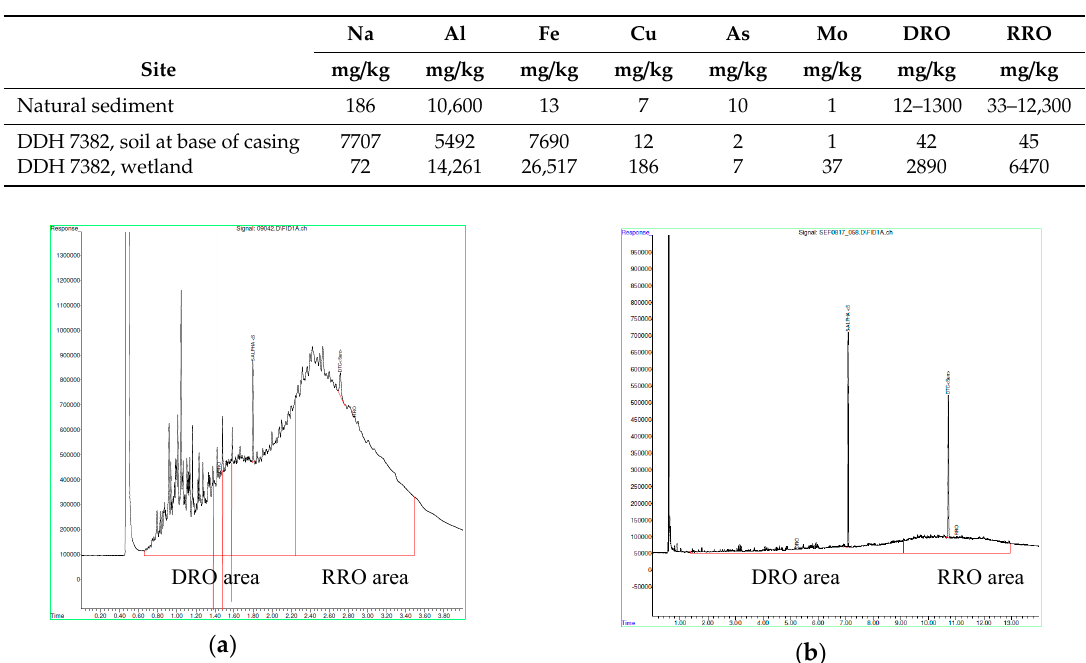
Table 3. DDH 7382, sediment. A putty-like material at the base of the leaking casing was sampled, along with wetland sediment several meters downgradient. “Natural Sediment” ( n = 197) is median concentrations from PLP [21], except Diesel Range Organics (DRO) and Residual Range Organics (RRO) are shown as ranges.